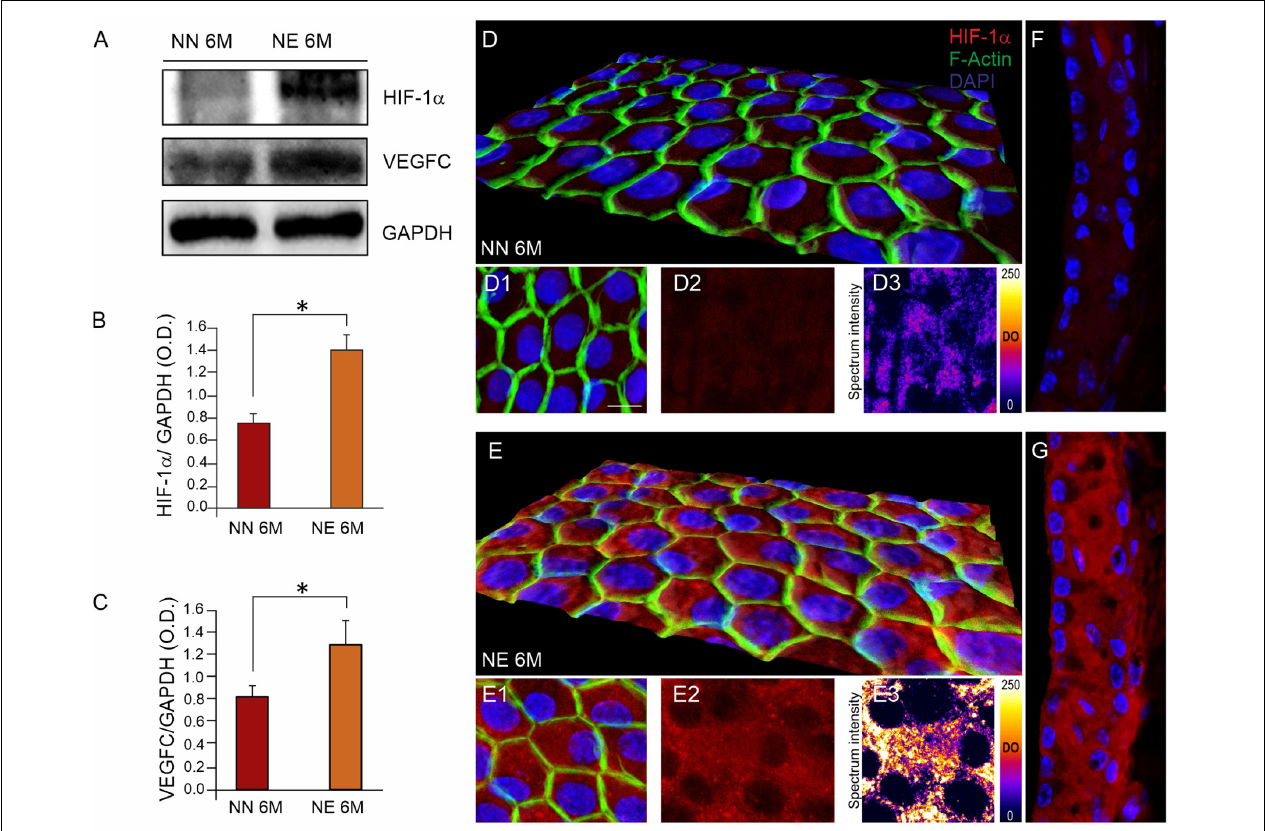
FIGURE 6 | Noise exposure enhances the age-related cochlear vascular damage. (A) Western immunoblotting showing cochlear overexpression of HIF-1 α and VEGFC in animals of 6 months of age (M) exposed to noise. (B,C) Histograms showing densitometry evaluations (optical density, O.D., proteins/GAPDH ratios). Data are expressed as mean ± SEM from three independent experiments. Asterisks indicate significant differences between groups ( ∗ p < 0.05) from Student’s t -test. (D,E) Representative 3D reconstruction of confocal Z-stacks images of HIF-1 α expression [red fluorescence, (D2,E2) ] in stria vascularis whole-mounts stained with F-actin (green fluorescence) showing marginal cell monolayer in no noise-exposed (NN) and noise-exposed (NE) groups (D1,E1) . Distribution of HIF-1 α fluorescence signal is shown in a pseudo-color rainbow scale in panels (D3,E3) . (F,G) Representative images of stria vascularis cryosections stained for HIF-1 α (red fluorescence) and DAPI (blue fluorescence) of NN (F) and NE (G) animals of 6 M confirming high expression of HIF-1 α induced by noise. Scale bar: 20 µ